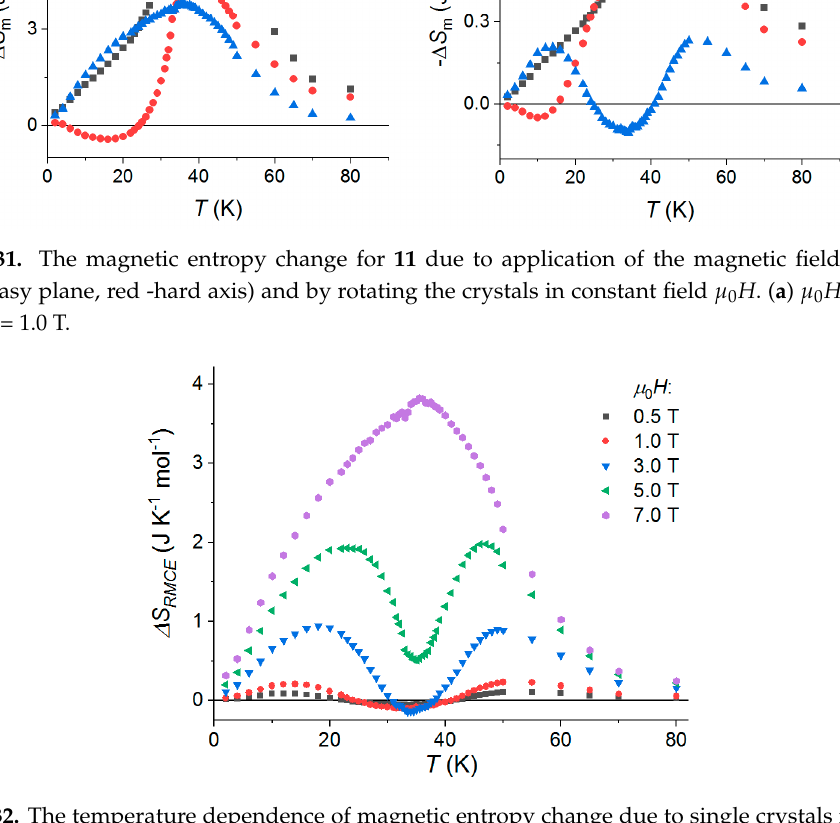
Figure 32. The temperature dependence of magnetic entropy change due to single crystals rotation in the constant field for 11 . Adapted with permission from Reference [71] Copyright 2017 American Chemical